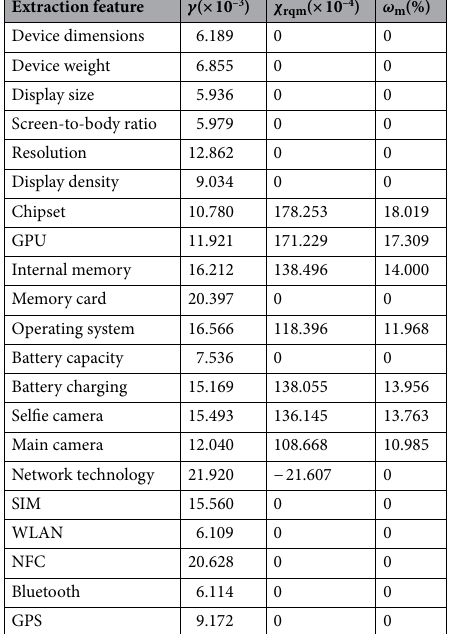
Table 4. The values of γ , χ rqm , and ω m of each extracted